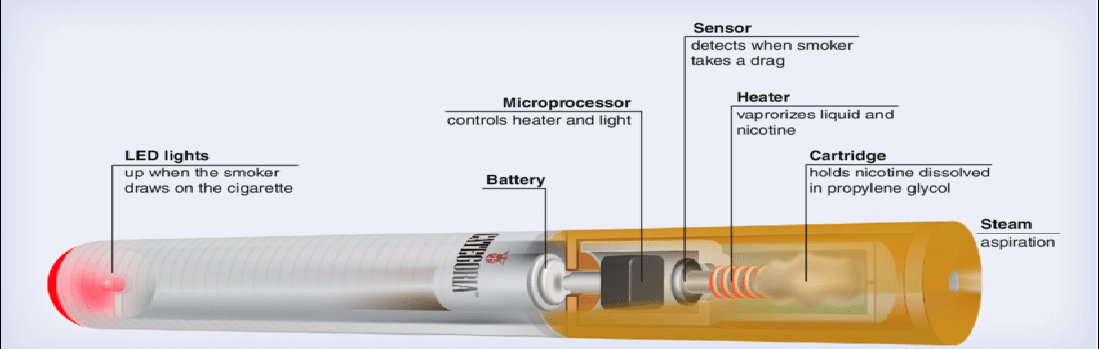
Figure 1. Structure of the e-cigarette (Caponnetto et al., 2012)